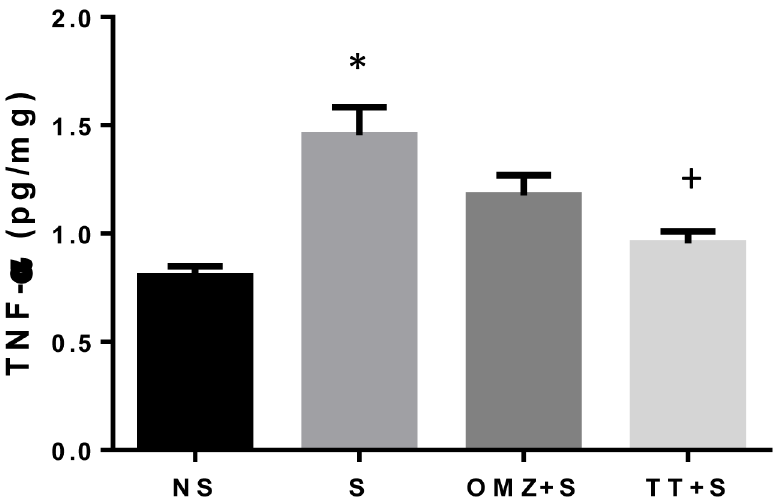
Fig 7. Effects of pre-treatment with tocotrienol (60 mg/kg BW) (TT) or omeprazole (20 mg/kg BW) (OMZ) on gastric Tumor necrosis factor alpha (TNF- α ) protein concentration in rats exposed to water immersion restraint stress (n = 7). * vs non-stressed control (NS) (P < 0.05). + vs stressed control (S) (P < 0.05).